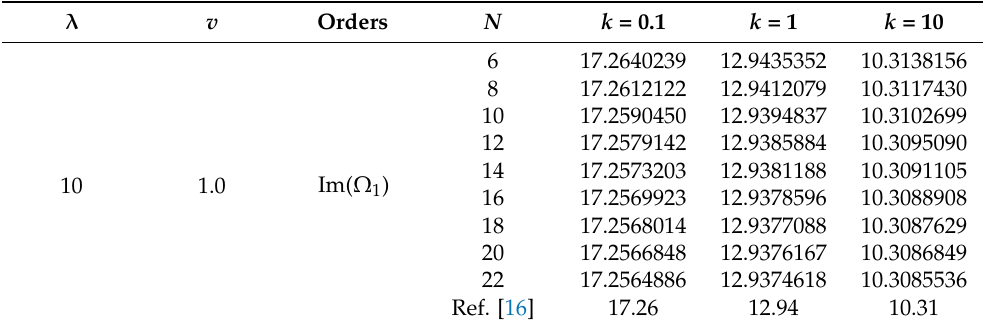
Table 1. The change of the natural complex frequency Ω 1 of an axially moving FGM beam with the number of discrete elements N of the beam Length.